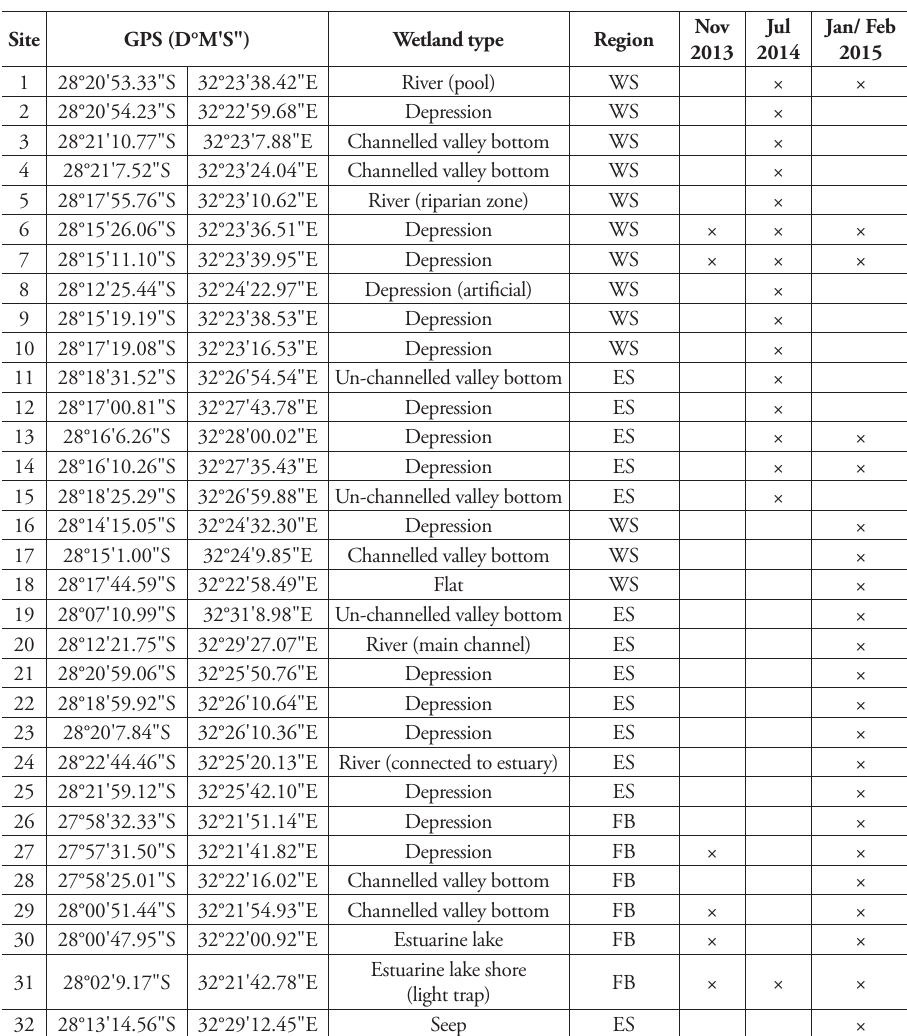
Table 1. Geographic position and classification of the waterbodies sampled during this study. Sampling took place during the three collecting trips to Lake St Lucia during November 2013, July 2014 and Janu- ary/February 2015. Classification (wetland type) follows the hydrogeomorphic (HGM) approach of Ollis et al. (2015). WS – Western Shores; ES – Eastern Shores; FB – False Bay. Table reproduced with permis- sion from Perissinotto et al.